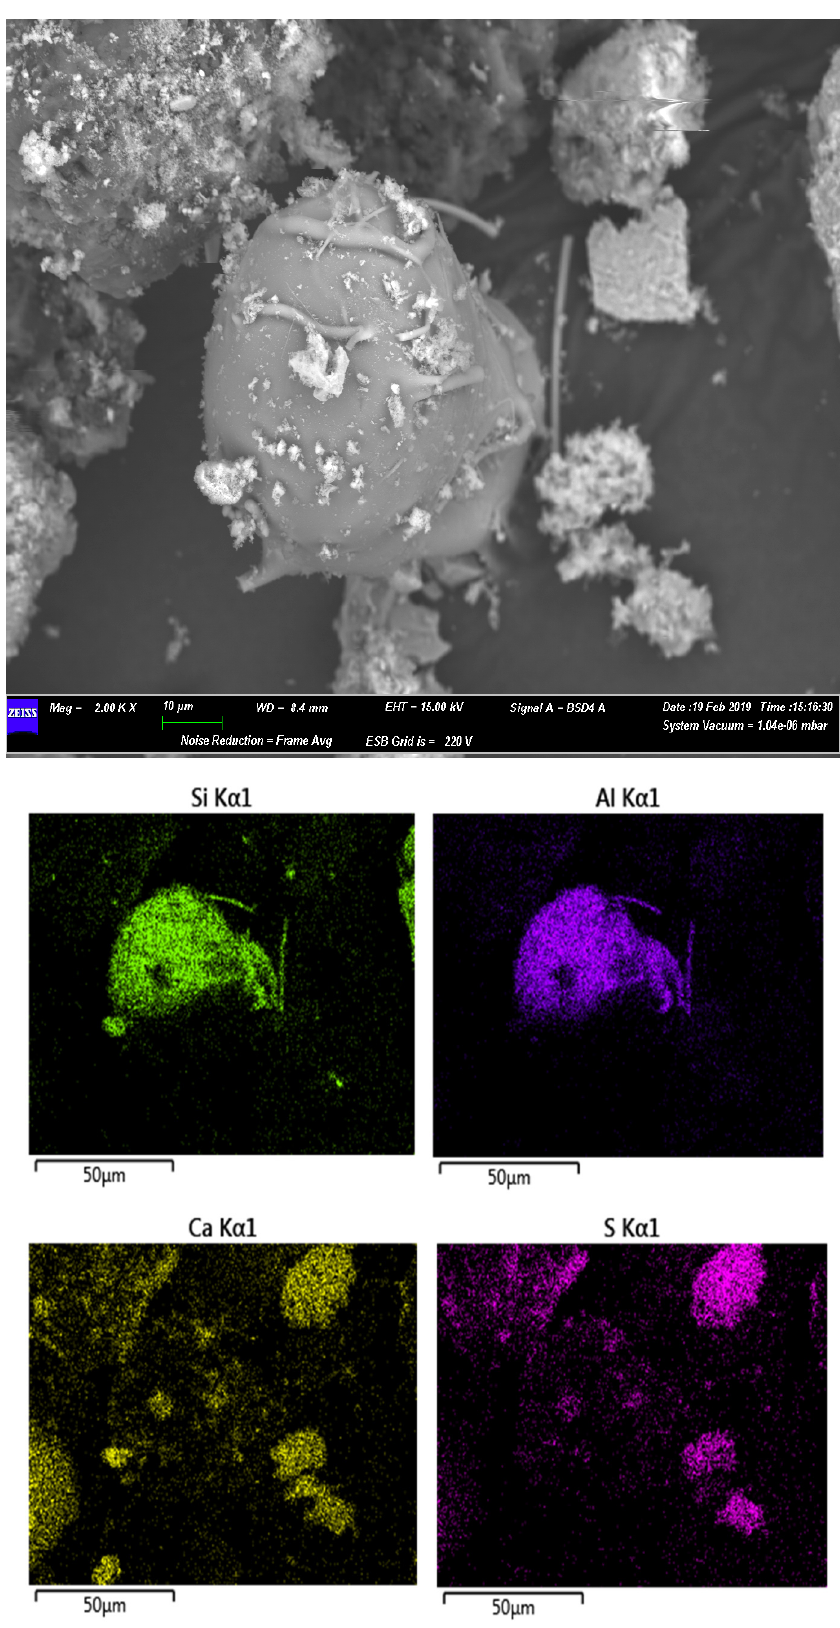
Figure 5. SEM/EDS of ash from lignite (image 2) . Figure 5. SEM / EDS of ash from lignite (image